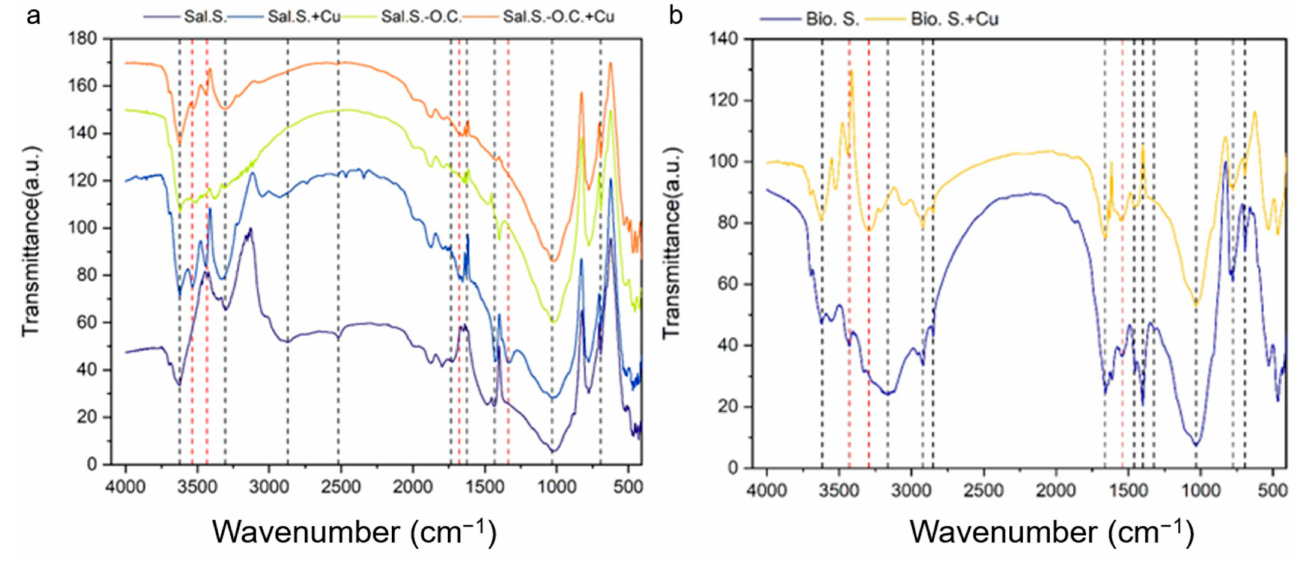
Figure 4. ( a ): The FTIR spectrums of SASs (Sal.S.) and adsorption Cu (Sal.S. + Cu), remove or- ganic matter (Sal.S.-O.C.) and adsorption Cu (Sal.S.-O.C. + Cu); ( b ): BR (Bio.S.) and adsorption Cu (Bio.S. +